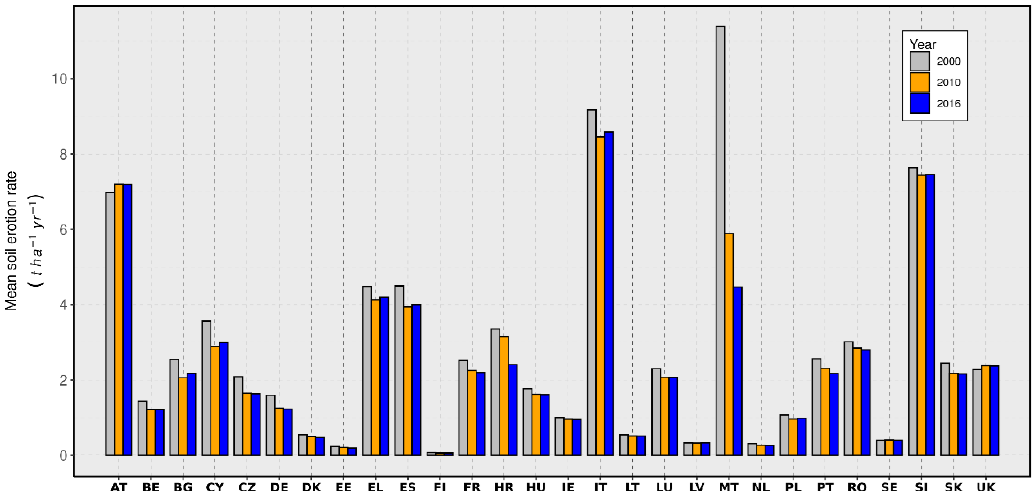
Figure 13. Estimated mean soil erosion rate per country.